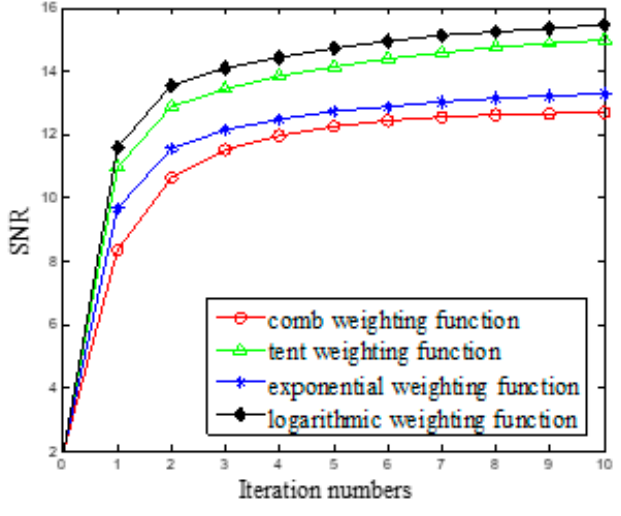
Figure 4. SNR values along with iterations.